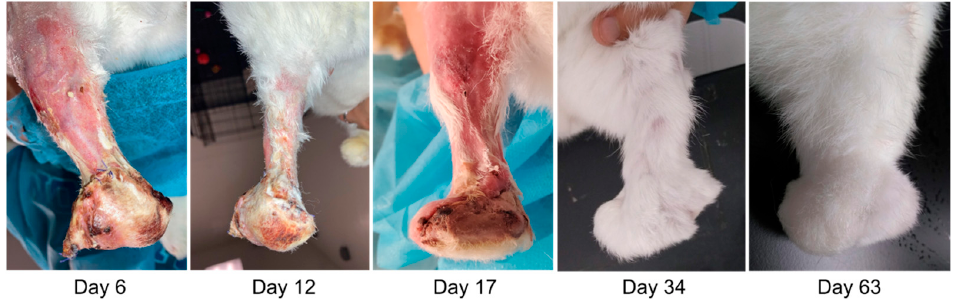
Figure 3. Progression of skin healing and fur regrowth up to 63 days post surgery (study endpoint) in rabbit E1.